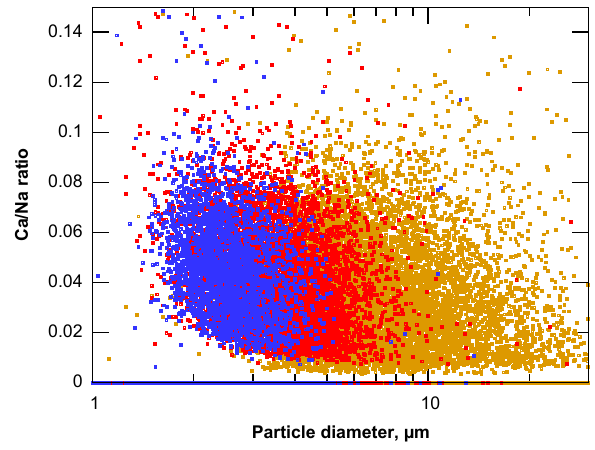
Figure 15. Ca / Na atomic ratio as function of particle dry diameter for all sea salt particles collected at Ragged Point in 2013. Different samplers are shown by color: CI is blue, DPDS is red and FWI is